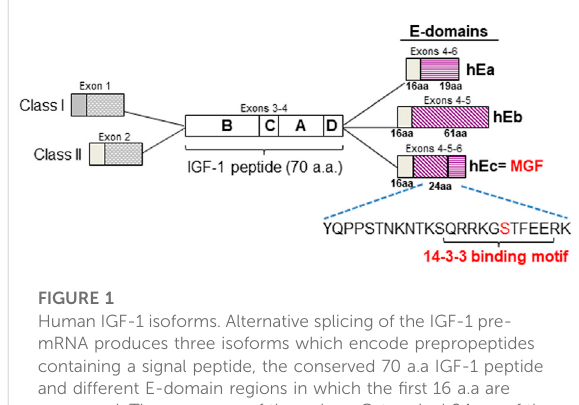
FIGURE 1 Human IGF-1 isoforms. Alternative splicing of the IGF-1 pre- mRNA produces three isoforms which encode prepropeptides containing a signal peptide, the conserved 70 a.a IGF-1 peptide and different E-domain regions in which the fi rst 16 a.a are conserved. The sequence of the unique C-terminal 24 a.a of the MGF isoform E-domain is shown. The putative phosphoserine (Ser 18 )site(showninred)resideswithintheputative14-3-3binding motif as